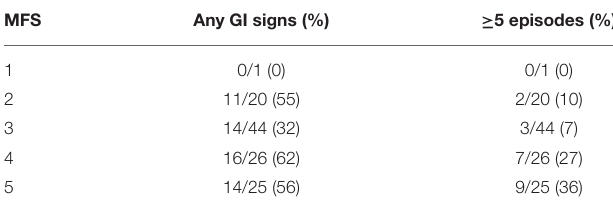
TABLE 2 | Gastrointestinal signs stratified by neurologic injury severity in 116 dogs undergoing surgery for TL-IVDE.